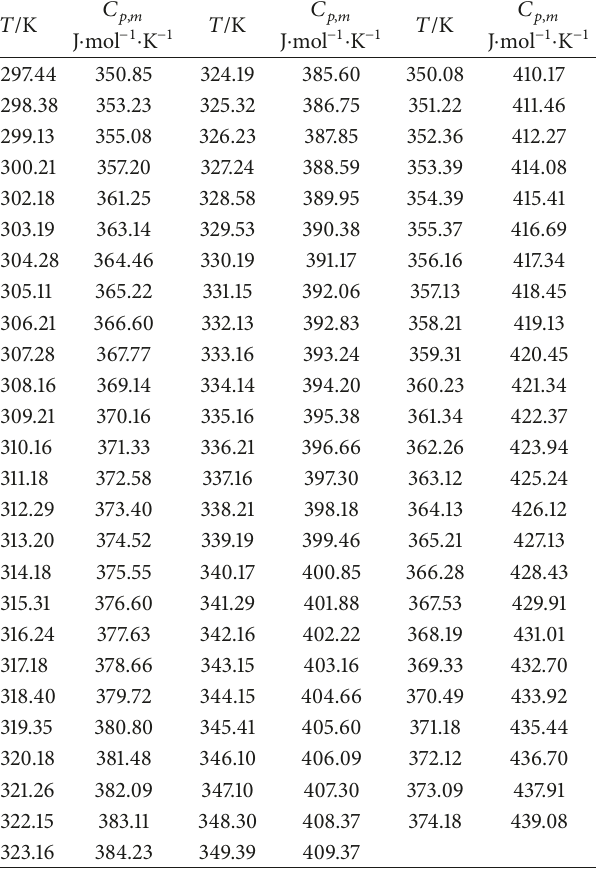
Table 3: Calculated molar heat capacities and thermodynamic functions of LiB 5 O 8 ⋅ H 2 O.